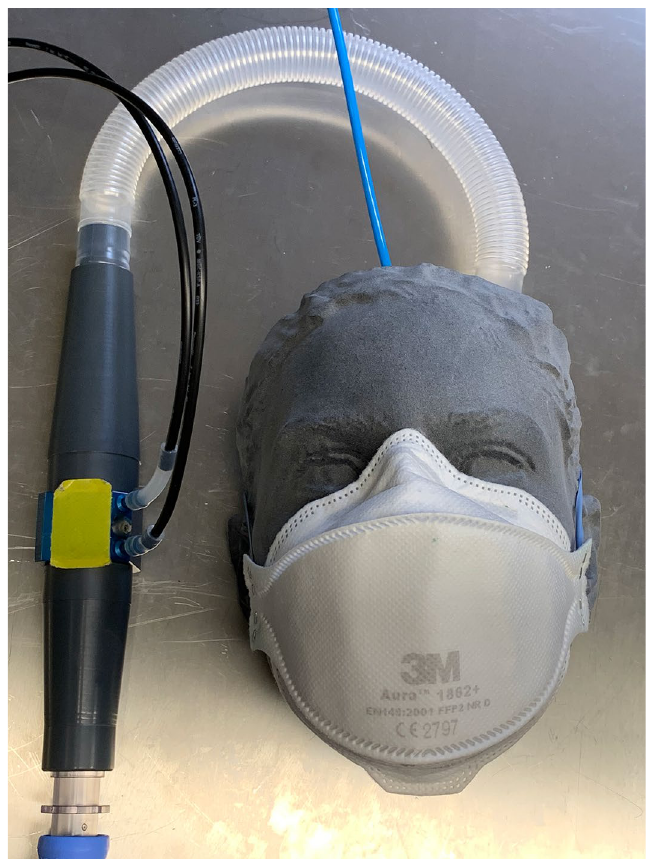
Figure 9. Measurement setup for the FFP2 mask while simulating human-like breathing. The pressure tubes exiting the obstruction flow meter (black) and the tube coming from the inside of the mask (blue) are connected to a pressure sensor array.